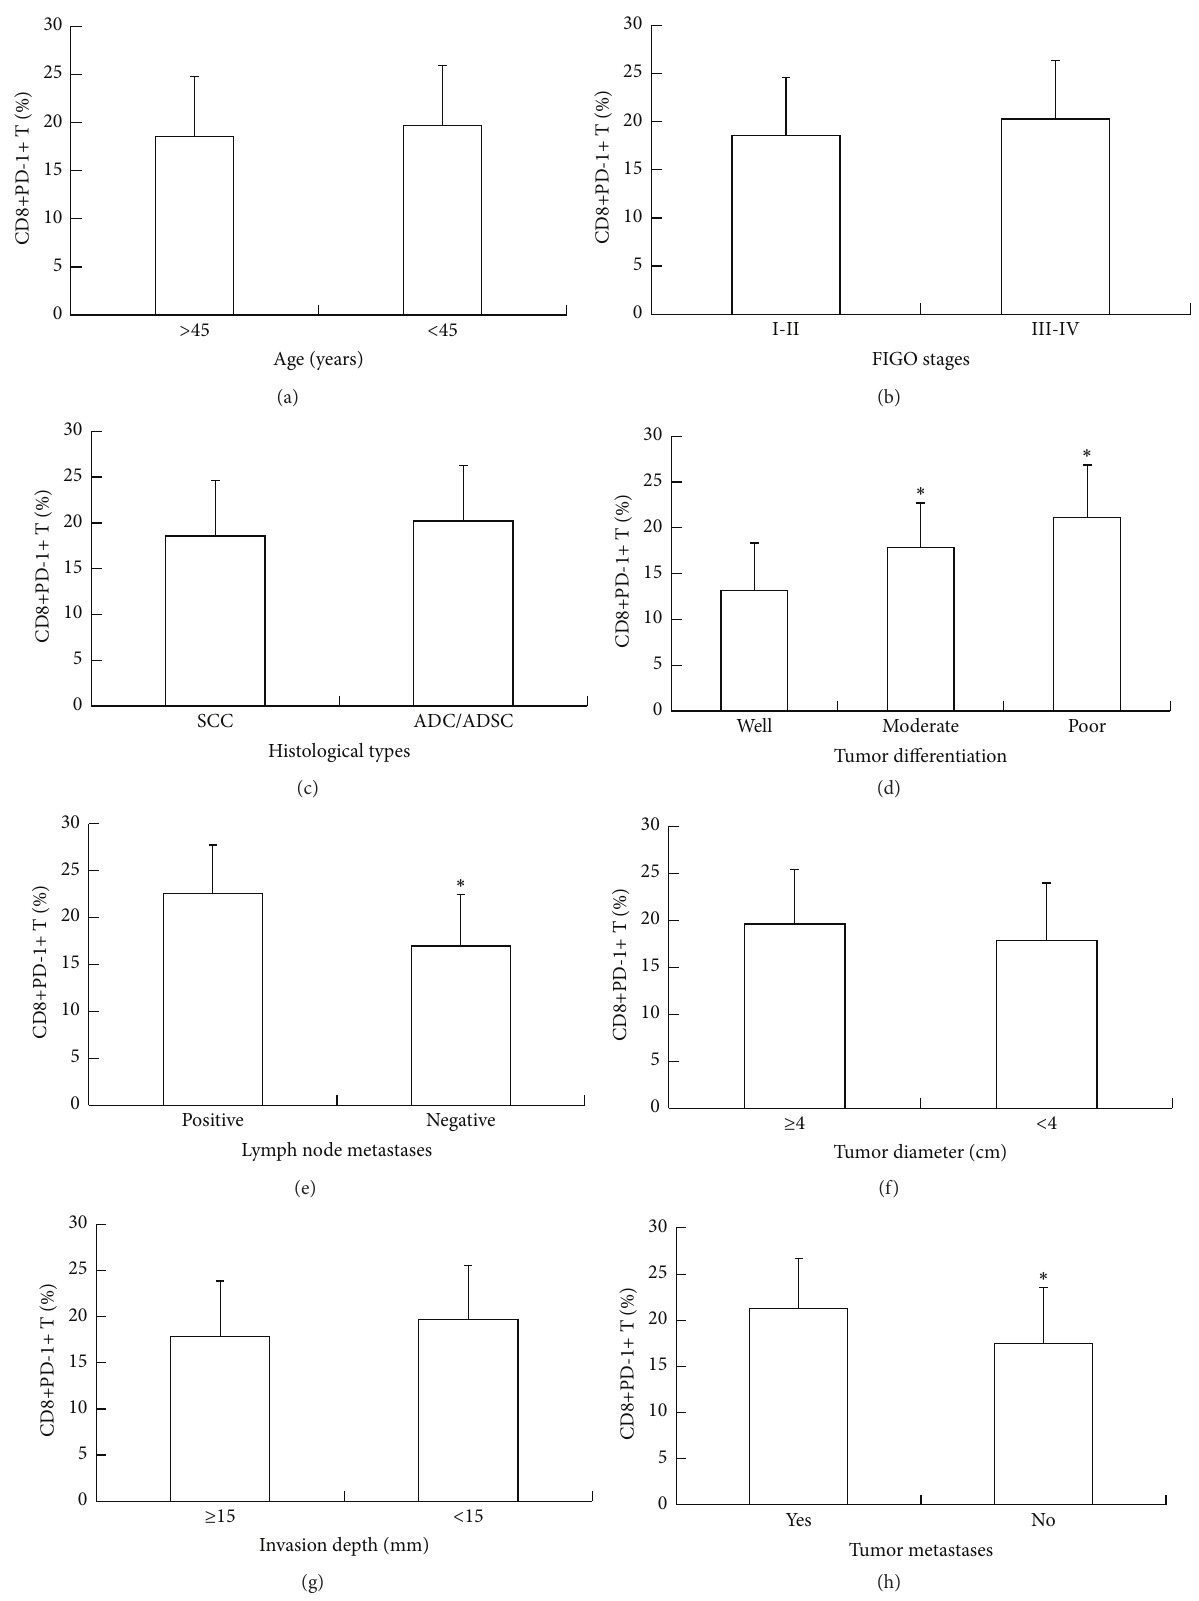
Figure 5: Relationship between PD-1 expression on CD8+T of cervical cancer patients and (a) age, (b) tumor staging, (c) histological types, (d) tumor differentiation, (e) lymph node metastasis, (f) tumor diameter, (g) invasion depth, and (h) tumor metastasis. ∗ 𝑃 < 0.05 compared with the group without “ ∗